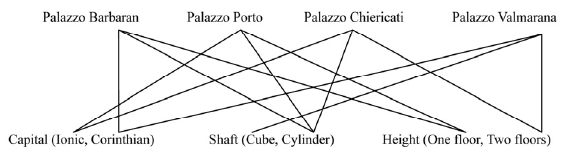
Figure 3. Options of rule 1 applied to Palazzo Barbaran, Palazzo